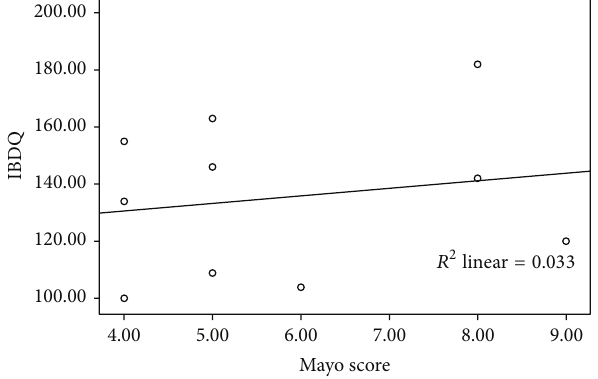
Figure 3: Linear correlation between the Inflammatory Bowel Disease Questionnaire score and Mayo score before and four weeks after fecal microbiota